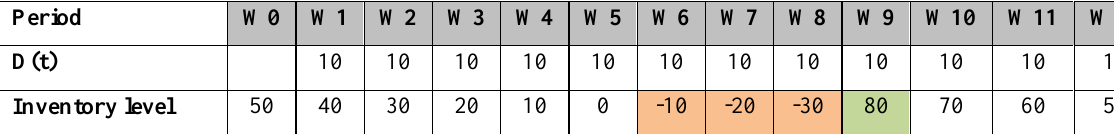
Table 6 : Supply Delay for P 2 During Weeks